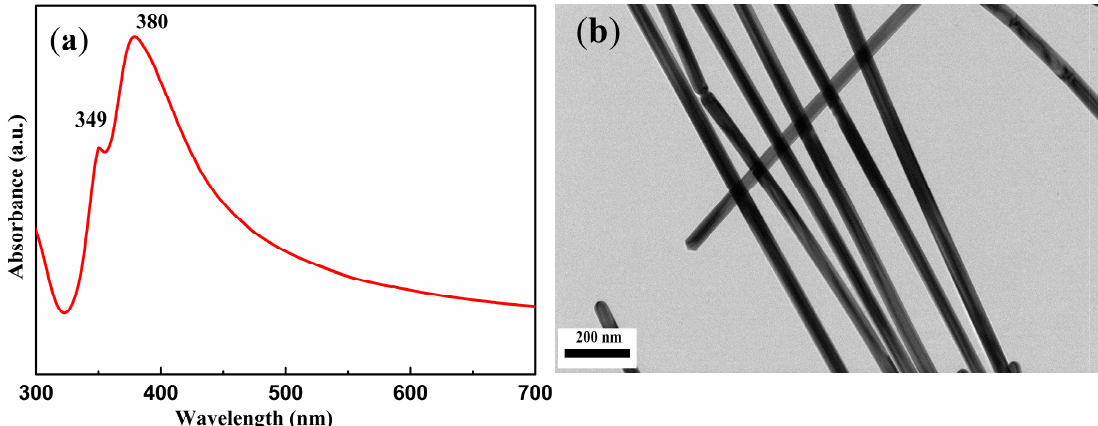
Figure 2. ( a ) Ultraviolet-visible (UV-Vis) absorbance spectrum of Ag nanowires; ( b ) transmission electron microscopy (TEM) images of Ag nanowires.